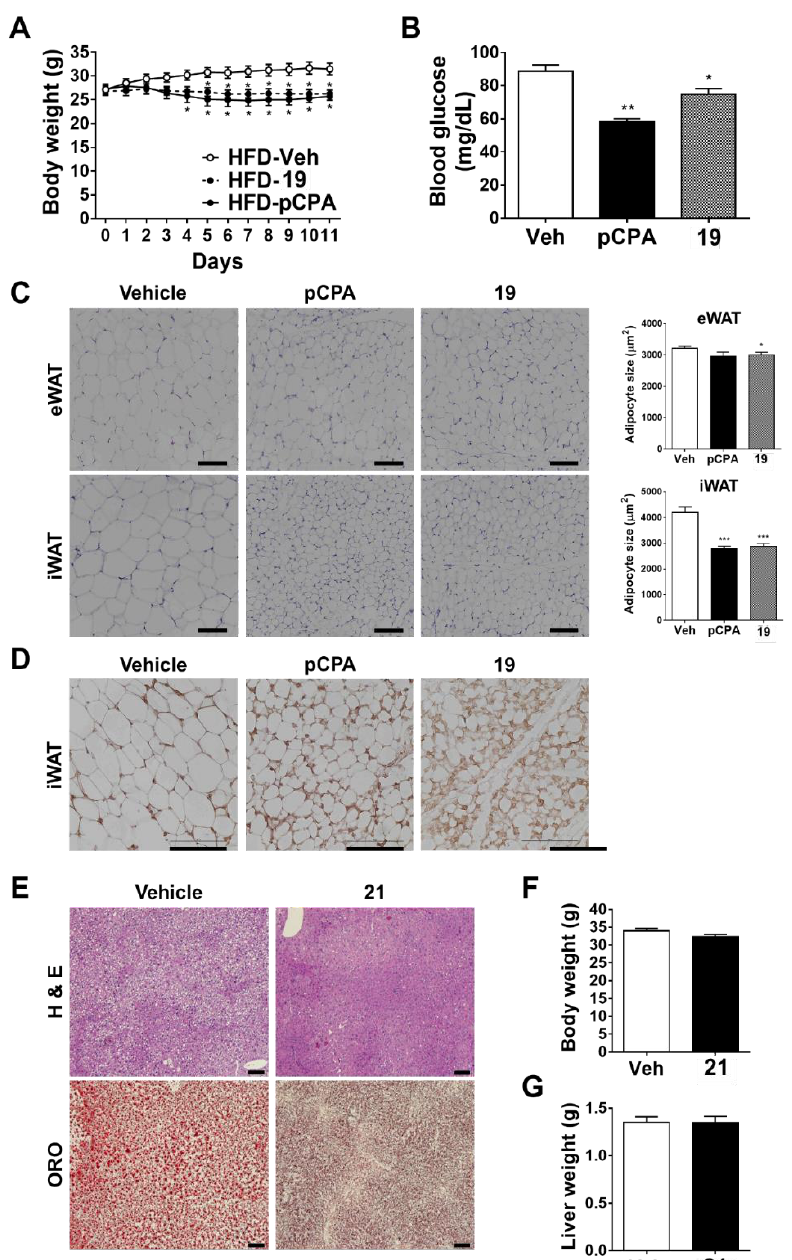
Figure 4. Compounds 19 and 21 show in vivo efficacy for obesity and fatty liver diseases. ( A ) Body weight of HFD-fed mice treated with vehicle ( n = 6), 300 mg kg −1 pCPA ( n = 3) or 100 mg kg −1 19 ( n = 4) for 11 days. ( B ) Fasting blood glucose levels in HFD-fed mice after treatment of vehicle ( n = 6), pCPA- ( n = 3) or 19 ( n = 4). ( C ) Representative H&E images of iWAT and eWAT from vehicle-, pCPA- or 19 -treated mice fed a HFD (left, scale bar = 100 μm). The average adipocyte cross-section area of iWAT and eWAT measured from H&E images (right). ( D ) Immunohistochemistry of UCP1 protein in iWAT sections from HFD-fed mice treated with vehicle, pCPA, or compound 19 (scale bar = 100 μm) ( E ) Representative liver sections stained with H&E and Oil-red O (ORO) from HFD-fed mice treated with vehicle or compound 21 (scale bar = 100 μm). ( F ) Body and ( G ) liver weights after 6 weeks of vehicle or compound 21 treatment to HFD-fed mice. * p < 0.05, ** p < 0.01 and *** p < 0.001 vs. vehicle by Student’s t -test. Data are presented as mean ± s.e.m. Docking studies revealed that compound 18i had optimal interactions with the cata- lytic and other important residues of TPH1, with predicted binding free energy of −14.33